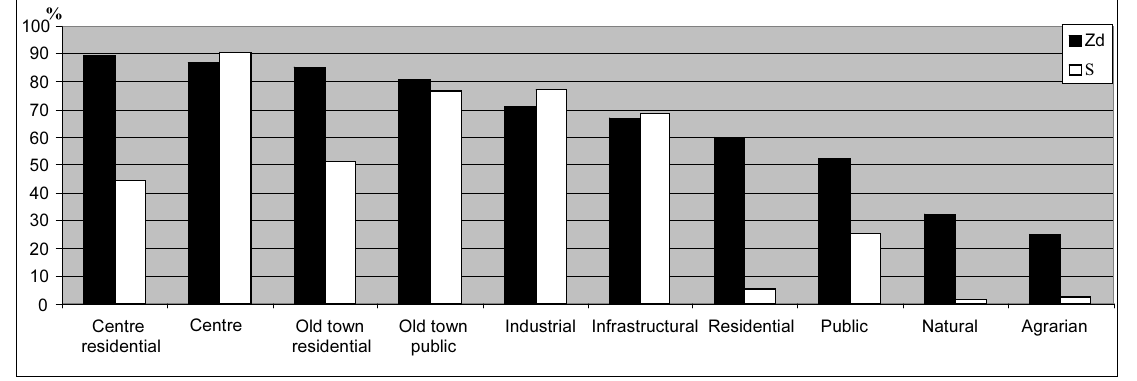
Fig. 6. Percentage of sites with unfavourable categories of Zd and S in different types of zones Table 3. Percentage of favourable and unfavourable sites in different types of zones Zones Favourable